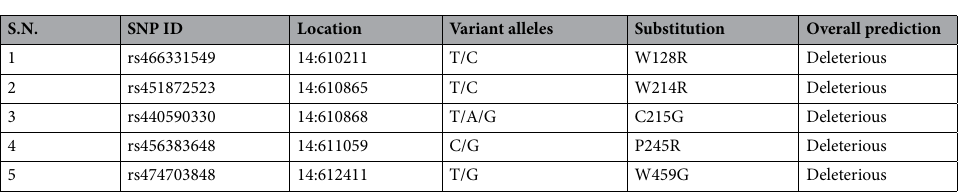
Table 1. A list of five selected missense nsSNPs predicted as deleterious by different sequence based tools. SIFT, PROVEAN, PredictSNP, MAPP, PhD-SNP, PolyPhen-1, PolyPhen-2, and SNAP were employed.